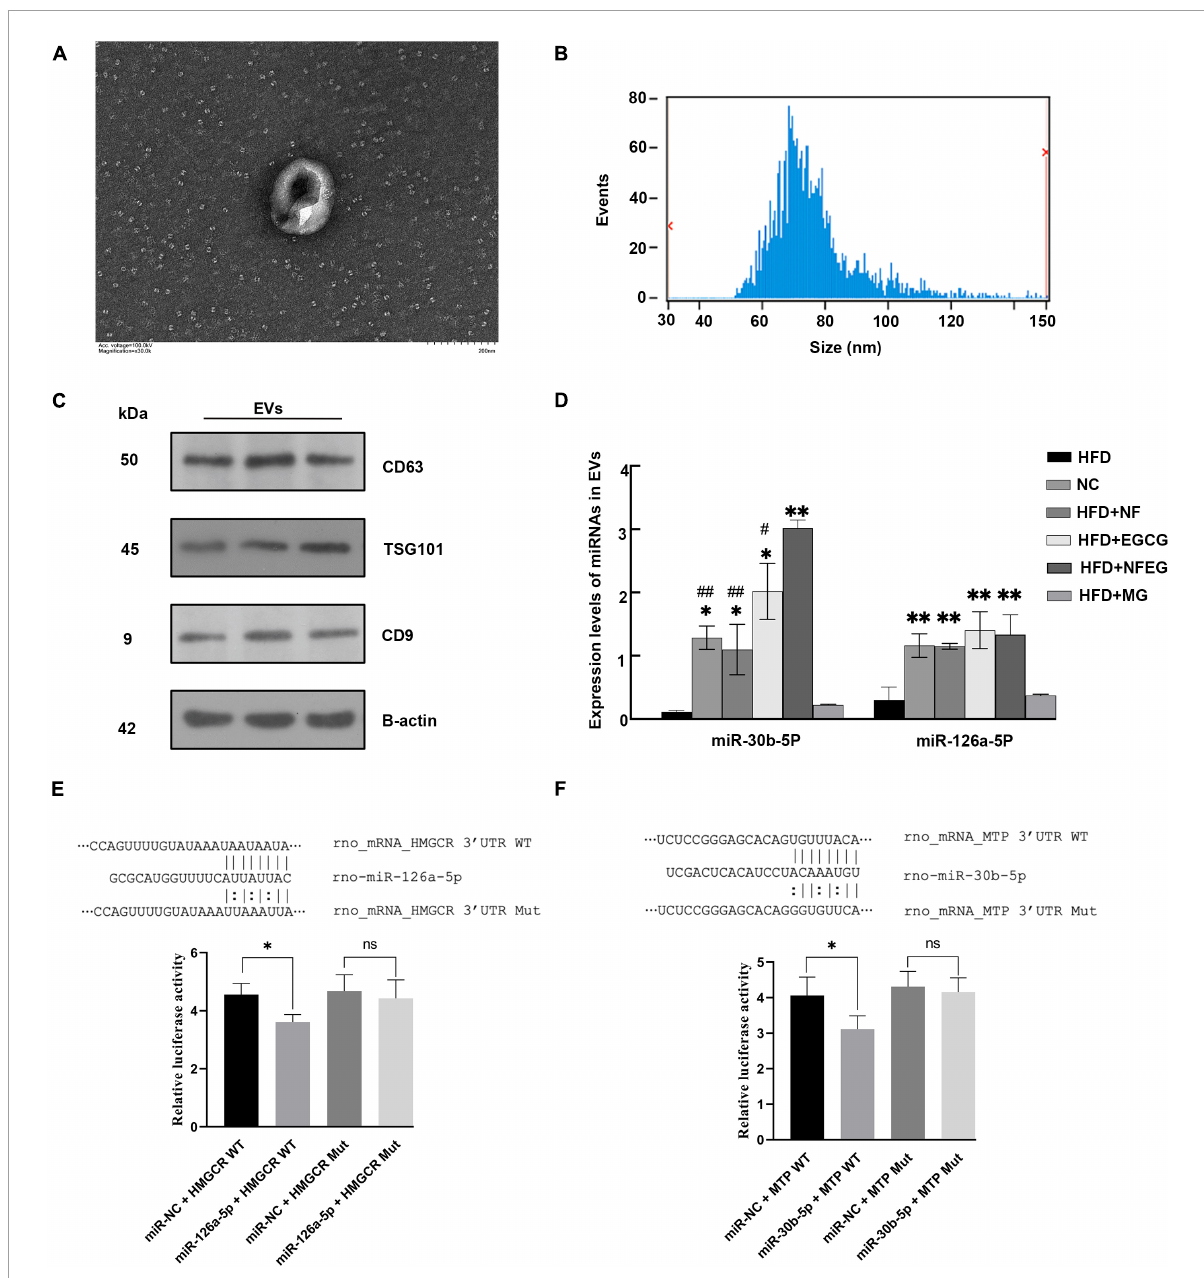
FIGURE5 Identification and miRNA expression level of EVs and dual-luciferase reporter assay analysis. (A) Serum EVs of different groups observed by transmission electron microscopy (TEM) at the scale of 200 nm. (B) Particle size analysis showing that the particle size of each exosome ranged from 50 to 140 nm. (C) Expression levels of CD9, CD63, and TSG101 determined by Western blot. (D) miRNAs were extracted from rat serum EVs, and their expression levels were detected by qRT-PCR. Significant difference was indicated with the sign (* P < 0.05) and (** P < 0.01) vs. HFD group; ( # P < 0.05) and ( ## P < 0.01) vs. HFD + NFEG group. Dual-luciferase reporter assay analysis: (E) the top portion of panel (E) shows the binding site of miR-126a-5p mimics and corresponding target genes HMGCR, and the bottom portion of panel (E) shows the